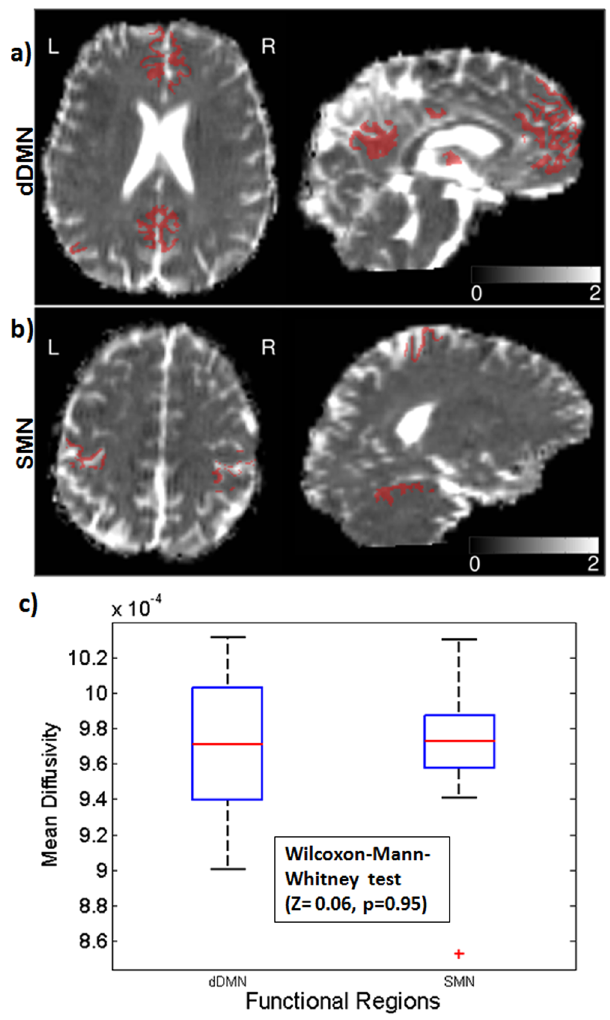
Figure 5. Mean Diffusivity within the dDMN and SMN. ( a ) dDMN and ( b ) SMN masks overlaid on a representative MD map. ( c ) The boxplot shows the mean MD in the dDMN and SMN mask for 11